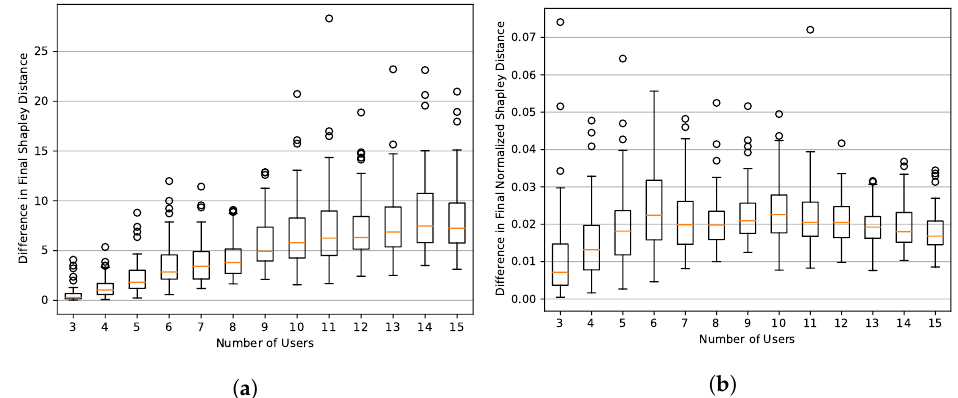
Figure 14. Boxplot of difference between final Shapley distance ( a ) and normalized Shapley dis- tance ( b ) of day-wise and full-period Shapley–core in 1000 trials separated by the number of users in the community.